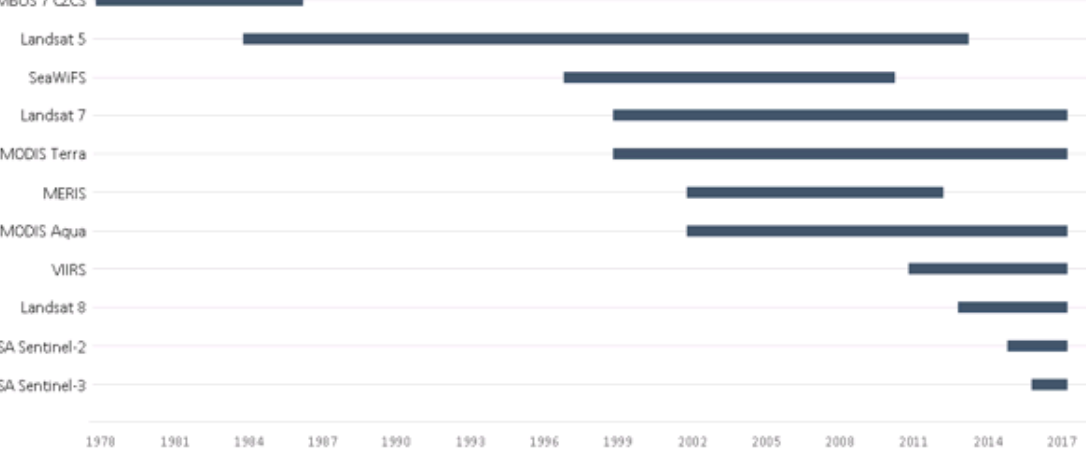
Figure 3: A selection of satellite missions since the 1970s that have collected ocean and land color